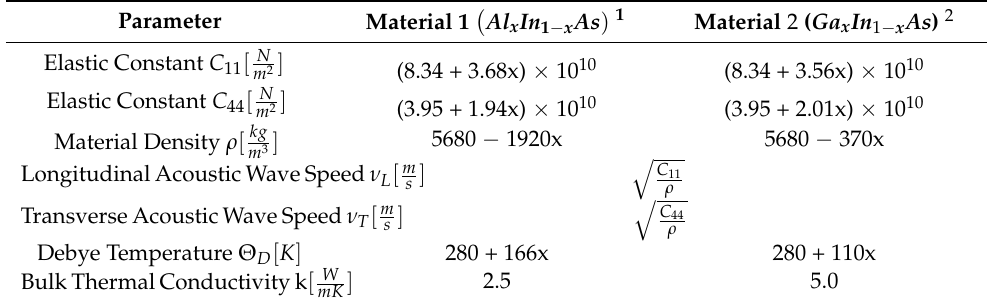
Table 2. Composition-dependent material parameters for TBR analysis.